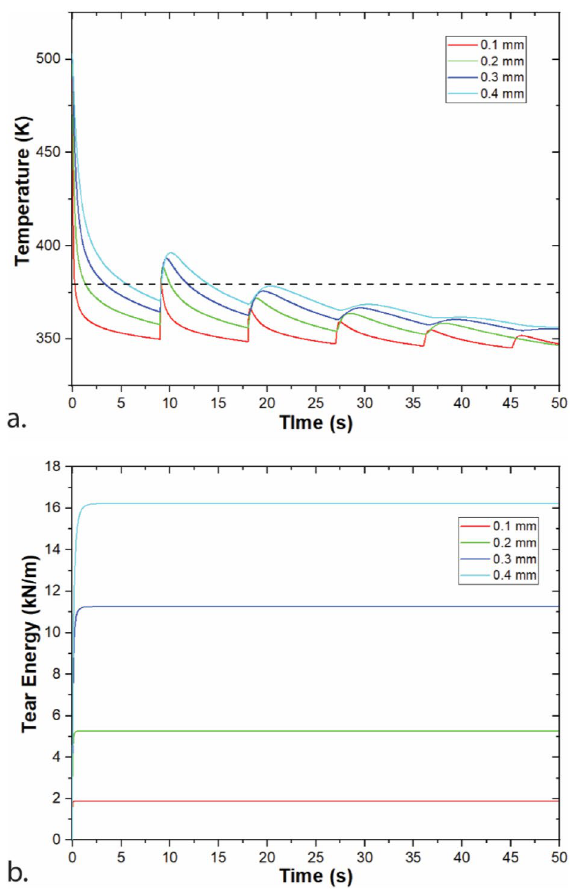
Figure 3. Modeling of a single-road width wall printing at a range of layer thicknesses with T ext = 230 °C, v print = 30 mm/s. ( a ) Temperature of the layer printed at a height of 2.4 mm (layer 24 for 0.1 mm, layer 12 for 0.2 mm, layer 8 for 0.3 mm, and layer 6 for 0.4 mm); ( b ) tear energy for the weld at 2.4 mm. Note that time represents start of layers at same